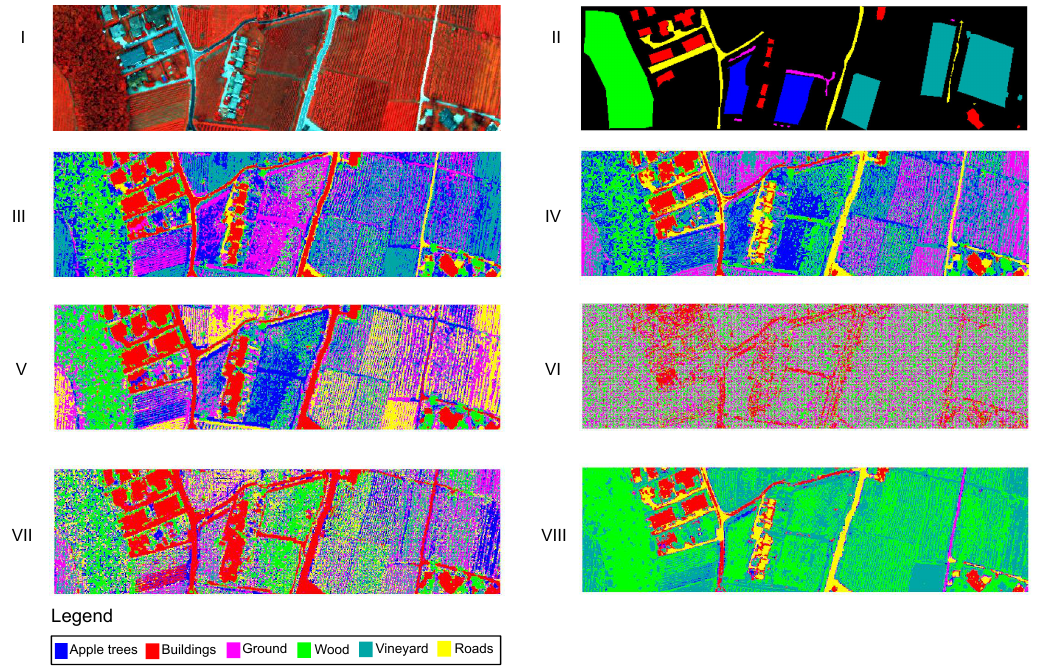
Figure 6. Trento dataset: (I) a false color map of the HSI using bands 40, 20, and 10 as R, G, and B, respectively; (II) the reference data. Clustering results obtained by (III) K-means, (IV) FCM, (V) ECC, (VI) SSC-OMP, (VII) ESC, (VIII) HESSC. Note: due to the memory limitation, SSC was not possible to run over the Trento